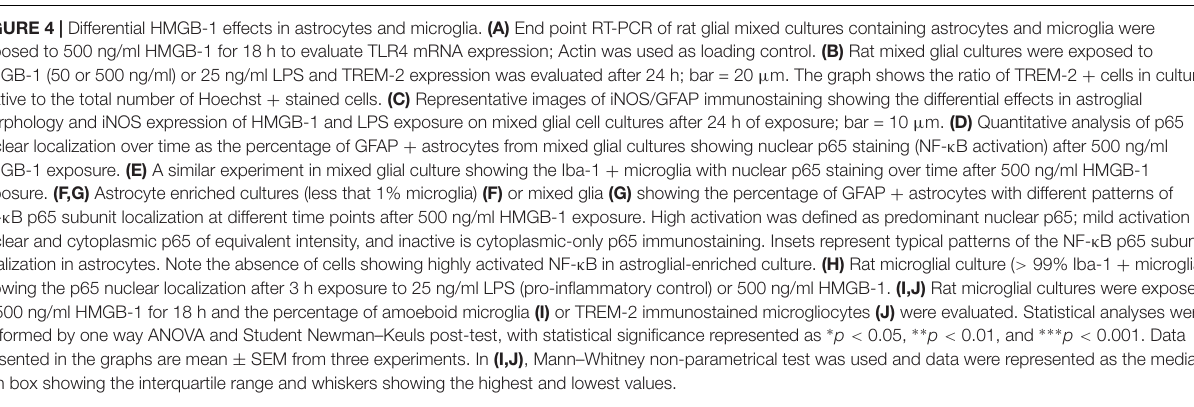
FIGURE 4 | Differential HMGB-1 effects in astrocytes and microglia. (A) End point RT-PCR of rat glial mixed cultures containing astrocytes and microglia were exposed to 500 ng/ml HMGB-1 for 18 h to evaluate TLR4 mRNA expression; Actin was used as loading control. (B) Rat mixed glial cultures were exposed to HMGB-1 (50 or 500 ng/ml) or 25 ng/ml LPS and TREM-2 expression was evaluated after 24 h; bar = 20 µ m. The graph shows the ratio of TREM-2 + cells in culture relative to the total number of Hoechst + stained cells. (C) Representative images of iNOS/GFAP immunostaining showing the differential effects in astroglial morphology and iNOS expression of HMGB-1 and LPS exposure on mixed glial cell cultures after 24 h of exposure; bar = 10 µ m. (D) Quantitative analysis of p65 nuclear localization over time as the percentage of GFAP + astrocytes from mixed glial cultures showing nuclear p65 staining (NF- κ B activation) after 500 ng/ml HMGB-1 exposure. (E) A similar experiment in mixed glial culture showing the Iba-1 + microglia with nuclear p65 staining over time after 500 ng/ml HMGB-1 exposure. (F,G) Astrocyte enriched cultures (less that 1% microglia) (F) or mixed glia (G) showing the percentage of GFAP + astrocytes with different patterns of NF- κ B p65 subunit localization at different time points after 500 ng/ml HMGB-1 exposure. High activation was defined as predominant nuclear p65; mild activation is nuclear and cytoplasmic p65 of equivalent intensity, and inactive is cytoplasmic-only p65 immunostaining. Insets represent typical patterns of the NF- κ B p65 subunit localization in astrocytes. Note the absence of cells showing highly activated NF- κ B in astroglial-enriched culture. (H) Rat microglial culture ( > 99% Iba-1 + microglia) showing the p65 nuclear localization after 3 h exposure to 25 ng/ml LPS (pro-inflammatory control) or 500 ng/ml HMGB-1. (I,J) Rat microglial cultures were exposed to 500 ng/ml HMGB-1 for 18 h and the percentage of amoeboid microglia (I) or TREM-2 immunostained microgliocytes (J) were evaluated. Statistical analyses were performed by one way ANOVA and Student Newman–Keuls post-test, with statistical significance represented as ∗ p < 0.05, ∗∗ p < 0.01, and ∗∗∗ p < 0.001. Data presented in the graphs are mean ± SEM from three experiments. In (I,J) , Mann–Whitney non-parametrical test was used and data were represented as the median with box showing the interquartile range and whiskers showing the highest and lowest